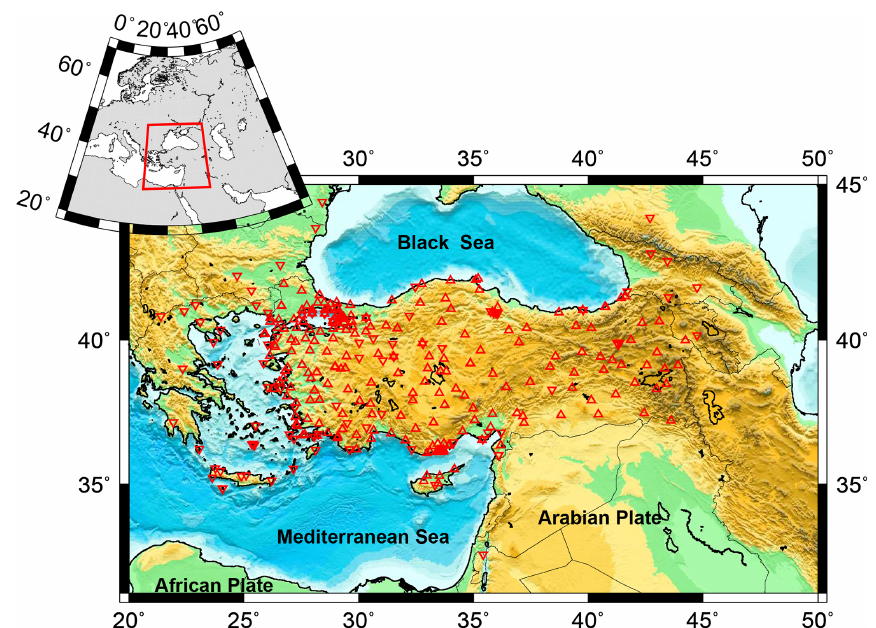
Figure 1. Station distribution used in earthquake location from RETMC network (triangles) and other stations from neighbourhood coun- tries (reverse triangles). The red rectangle in the inset figure shows the monitoring area of KOERI-RETMC (30.000–48.000 ◦ N, 22.000– 44.000 ◦